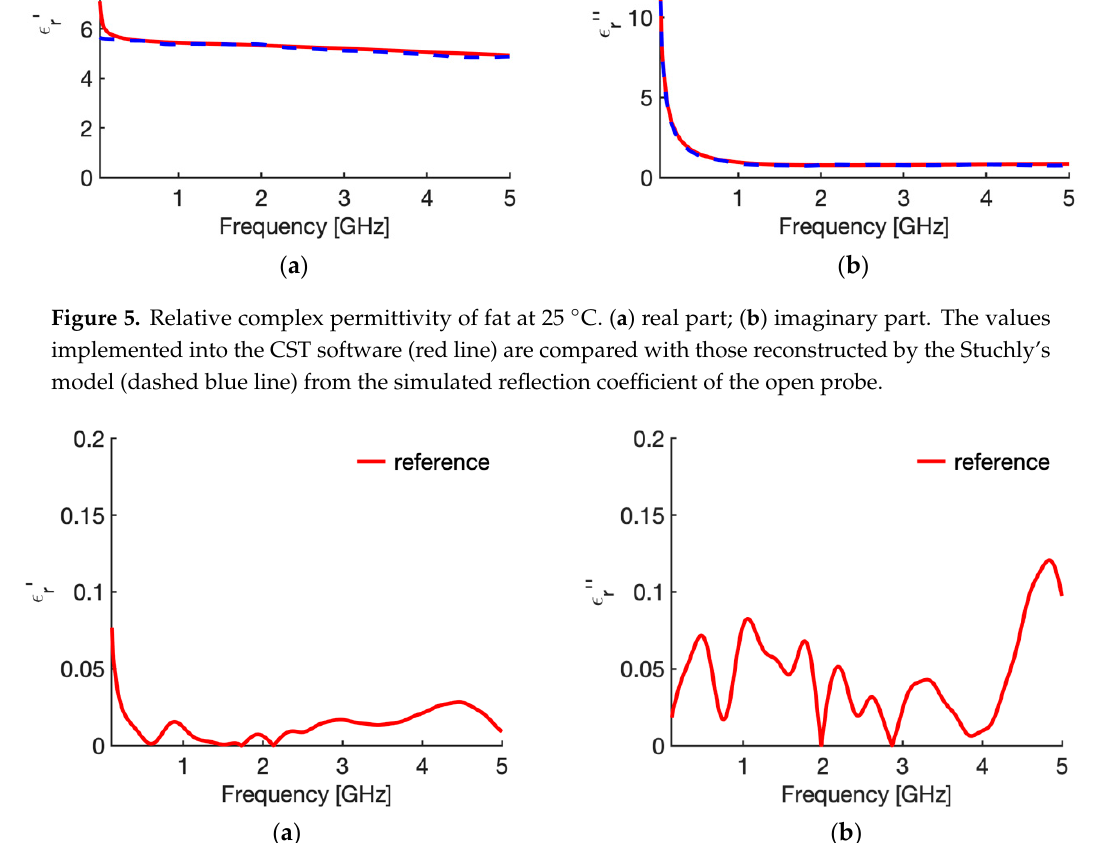
Figure 6. Percentage errors in the evaluation of the relative complex permittivity of fat at 25 °C through the reflection arrangement of the open probe technique. ( a ) real part; ( b ) imaginary part.